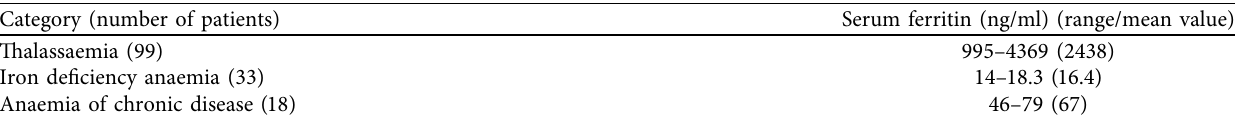
Table 2: Serum ferritin value in different subsets of anaemic population.